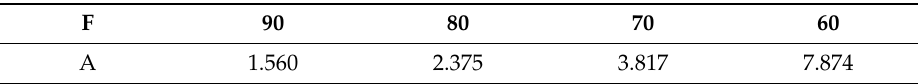
Table 2. Value of A corresponding to different F .